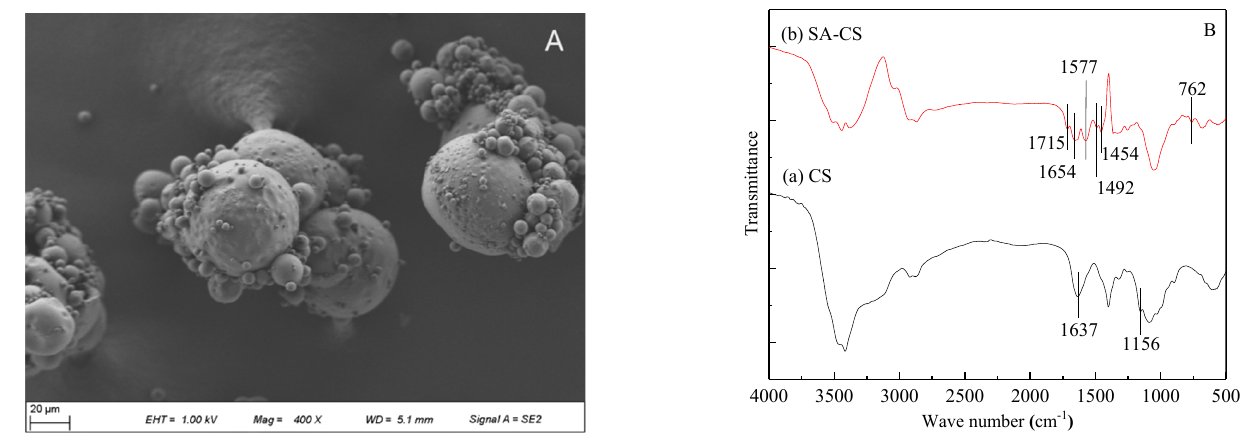
Figure 2. SEM of SA-CS and IR spectra of CS and SA-CS: ( A ) SEM of SA-CS; ( B ) IR spectra of (a) CS and (b) SA-CS.